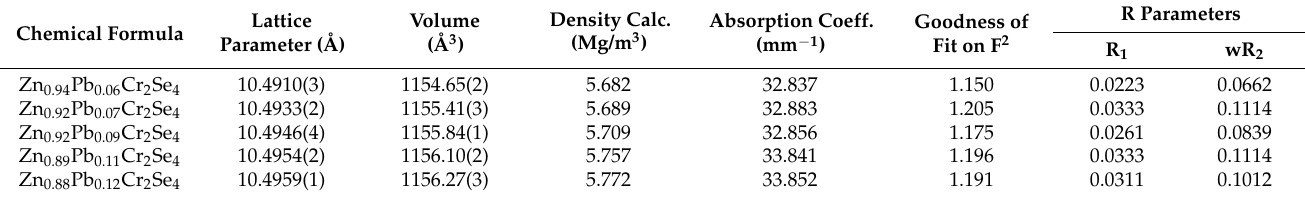
Table 2. Structural parameters of the Zn 1-x Pb x Cr 2 Se 4 single crystals.